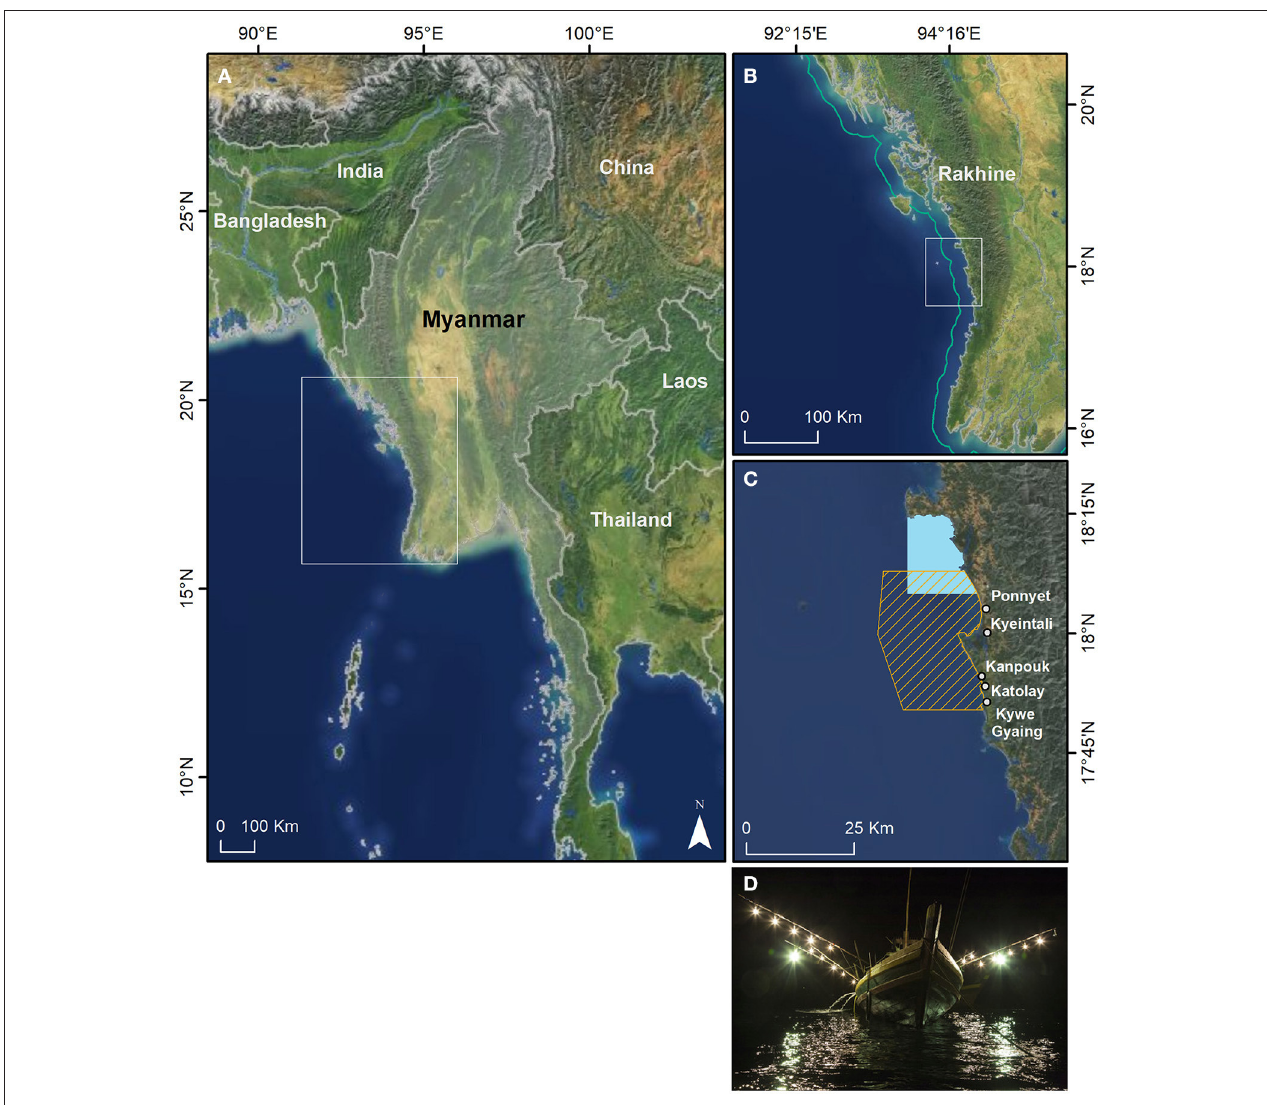
FIGURE 1 | Study region. (A) Myanmar, (B) Northern states of Rakhine and Ayeyarwady with the Inshore Fishery Zone highlighted (green line) and (C) Kyeintali region including key landing sites, the Kyeintali Inshore Fisheries Co-Management Association zone (orange has) and the Maw She Key Biodiversity area (blue box). (D) Image of light boat used by the local purse seine